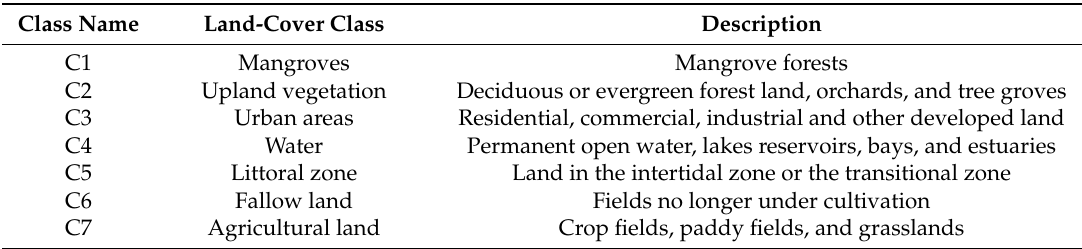
Table 1. Land-cover types in